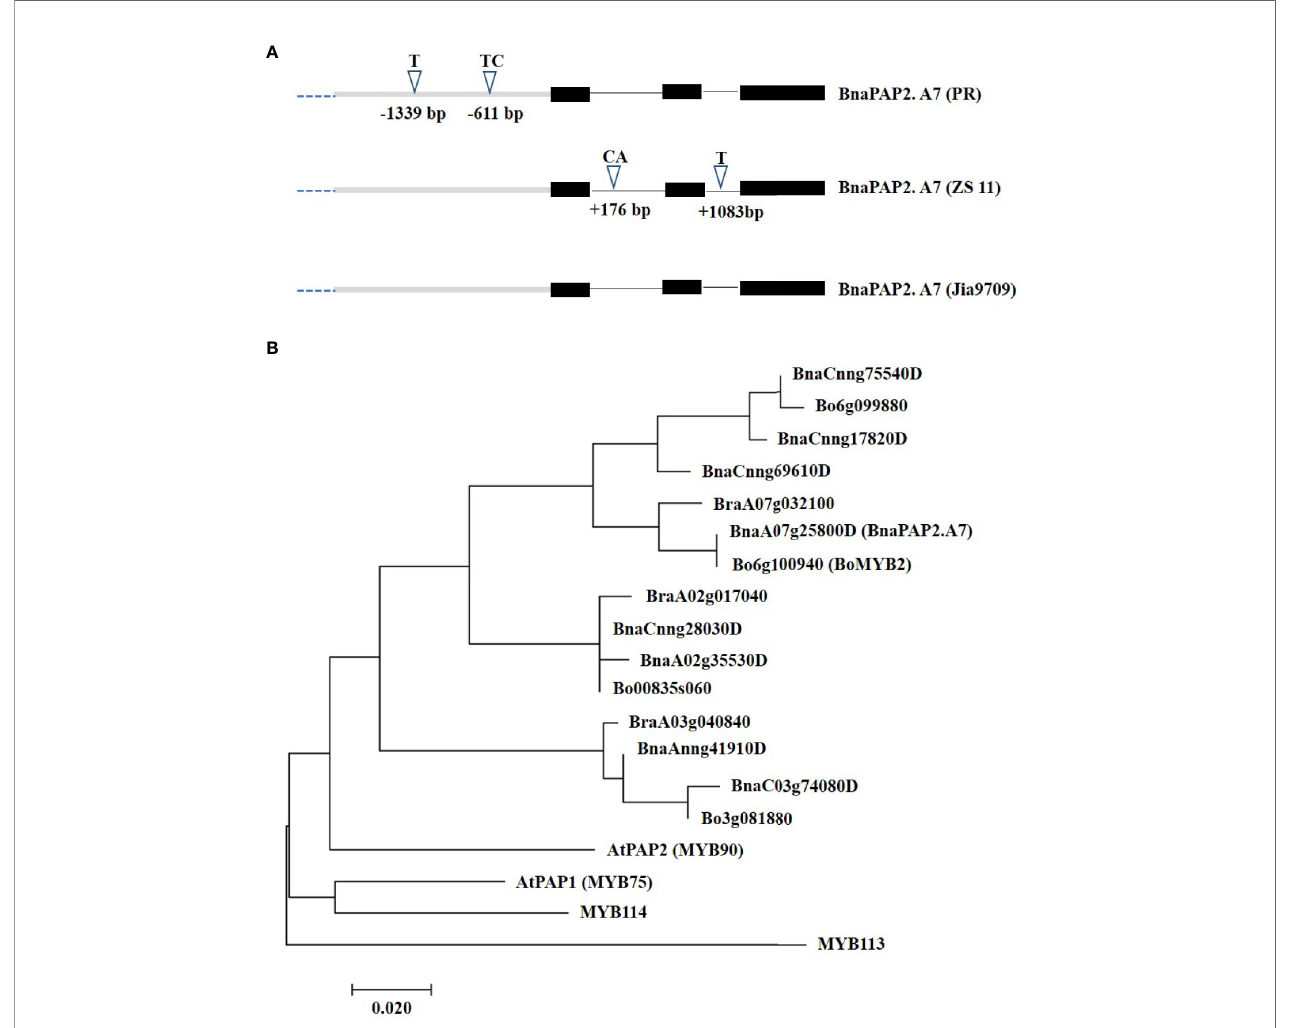
FIGURE 3 | Allelic variation and phylogenetic analysis of BnaPAP2. A7. (A) Allelic variation of BnaPAP2. A7 including 1.99 kb promoter region and 1.67 kb coding region between PR and ZS11. (B) Phylogenetic tree derived from amino acid sequences of R2R3-MYBs in B. napus , B. rapa , and B. oleracea showed homology to Arabidopsis